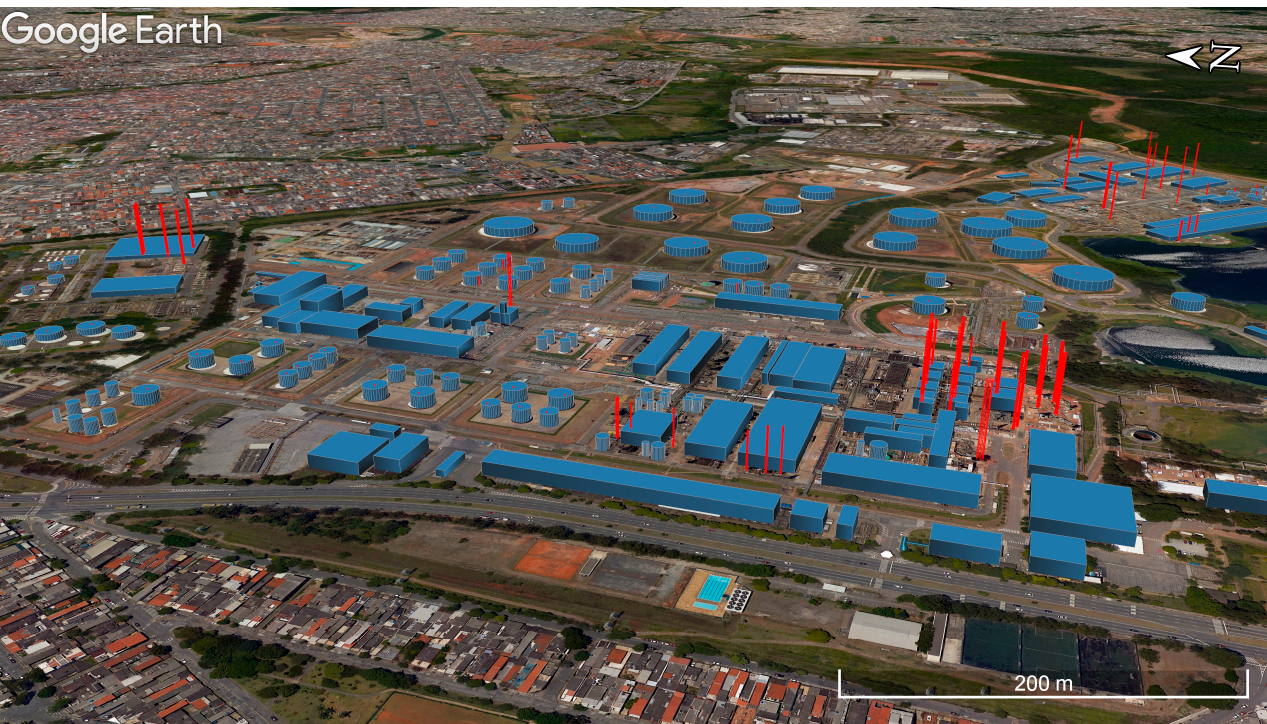
Figure 2. Braskem and RECAP industrial plants on tridimensional modeling. In blue are the buildings or tanks, in red are the point sources (stacks/flare). Source: Google Earth (accessed on 11 March 2023).